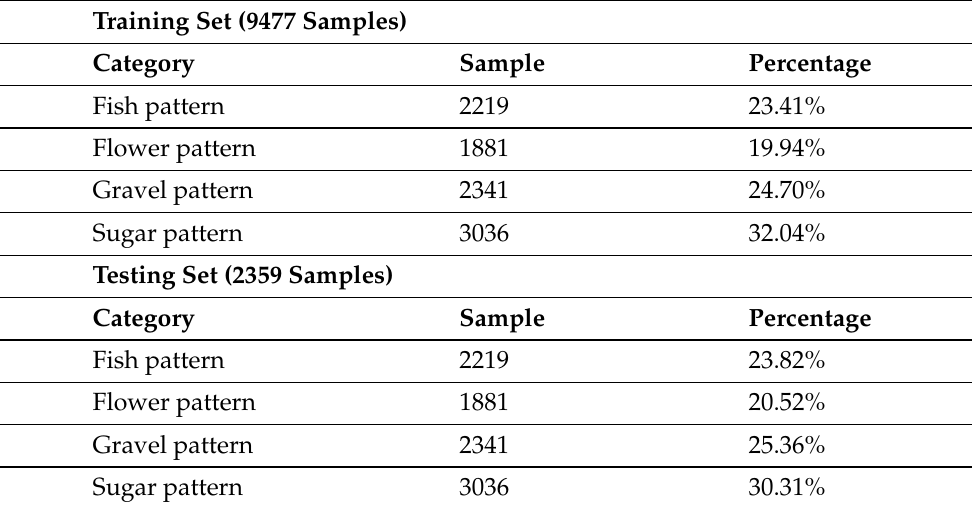
Table 1. Dataset